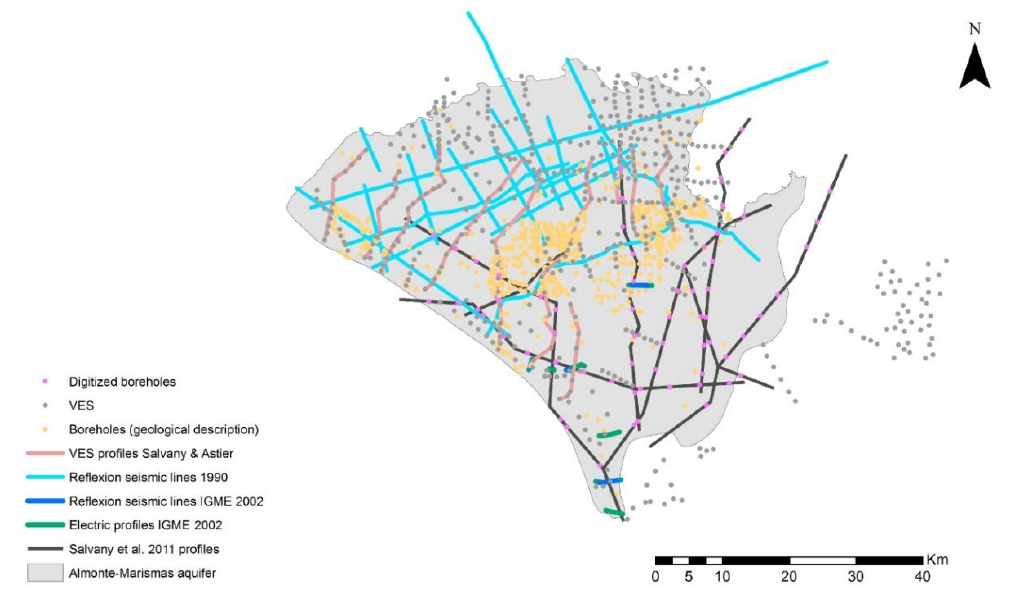
Figure 3. Spatial distribution of geological and geophysical information in Almonte-Marismas aquifer.